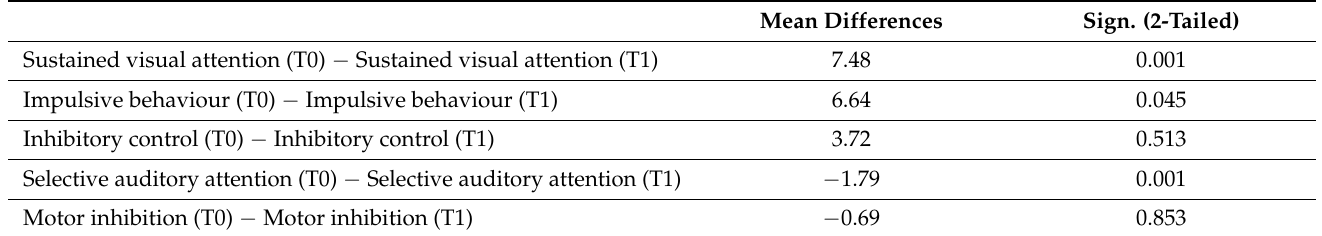
Table 10. Student’s t -test for difference between averages for paired samples of BIA test variables. Mean Differences Sign. (2-Tailed)